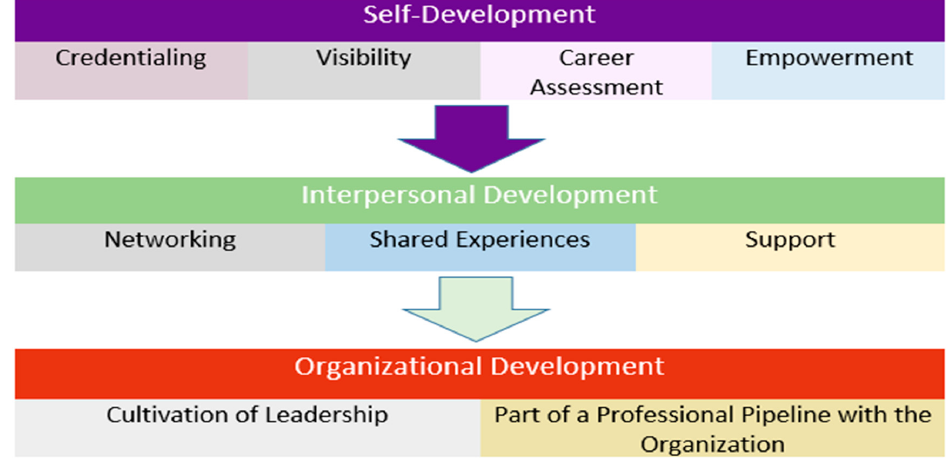
Figure 2. First Attempt at Defining Women’s Leadership Levels and Themes.